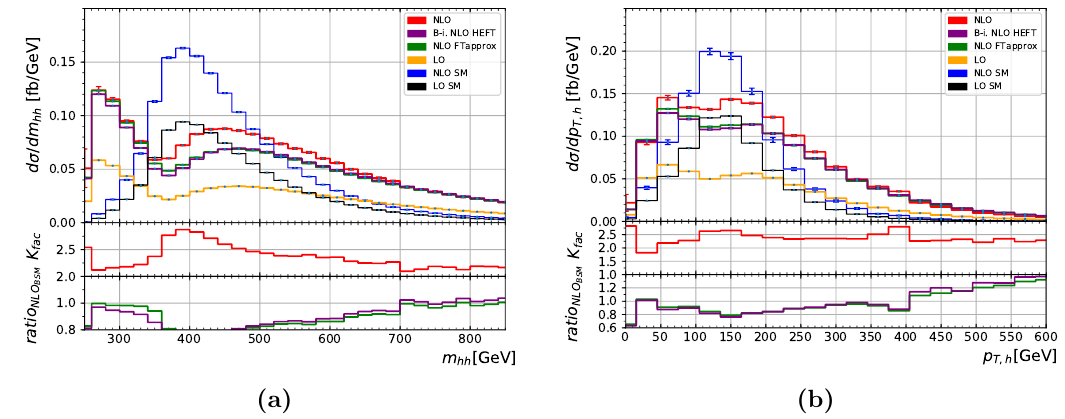
Figure 20. Same as (cid:12)gure 12 but for benchmark point 8a, c hhh = 1 ; c t = 1 ; c tt = 0 : 5 ; c ggh = 4 = 15 ; c gghh = 0.